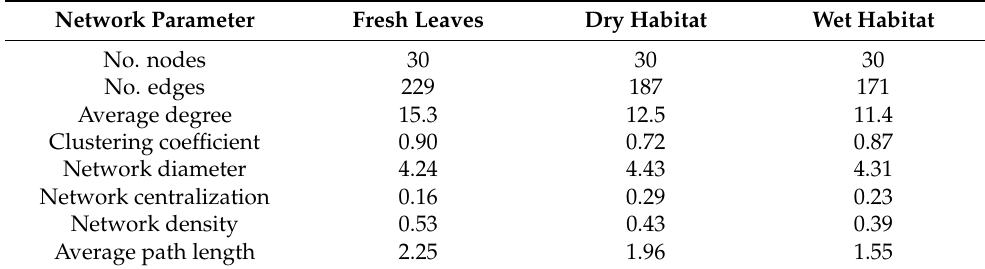
Table 2. Location-specific network